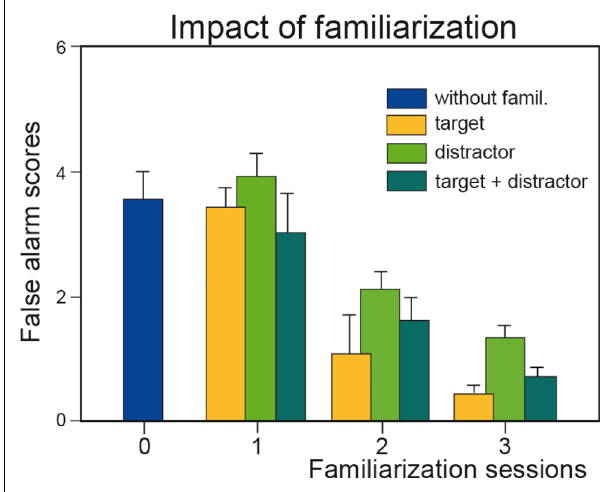
FIGURE 1 | Effect of familiarization. Number of incorrect recognitions (false alarm scores) as a function of the number of familiarization sessions (0, 1, 2, and 3) and of the type of odor (target, distractor, or both target and distractor) to which subjects were familiarized.Vertical bars, standard errors of the mean (modified from Jehl etal.,